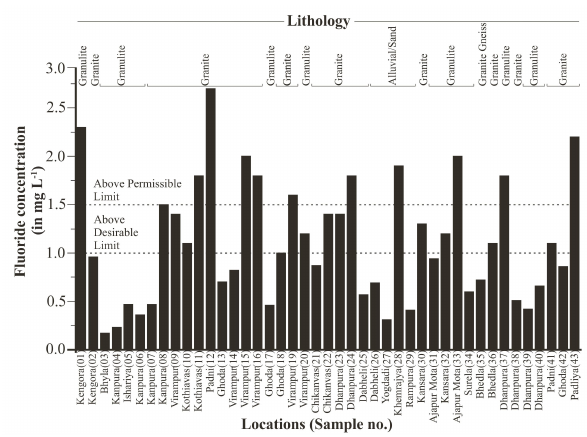
Figure 2. Spatial distribution of fluoride in groundwater of Ambaji